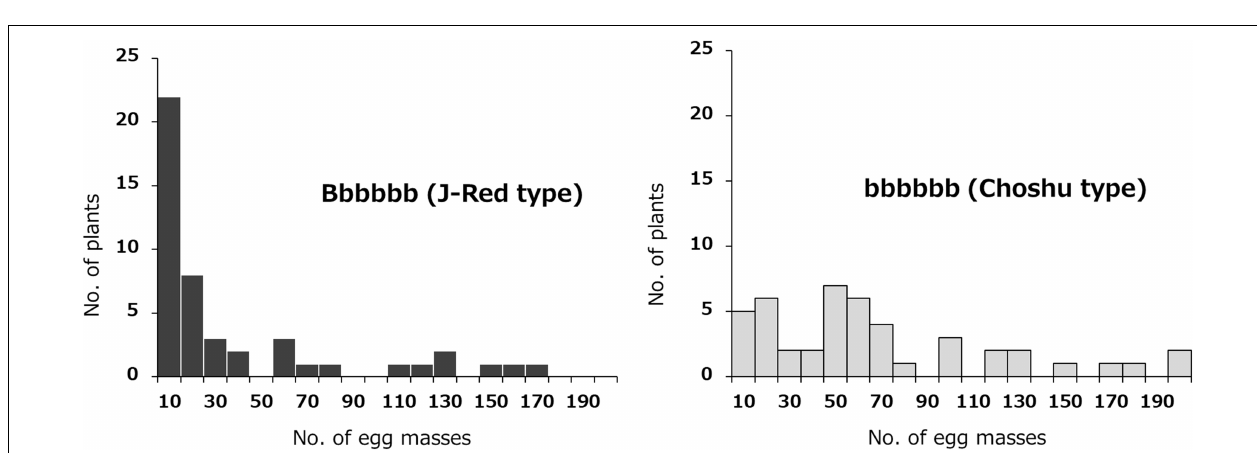
FIGURE 3 | Frequency distribution of the mean number of egg masses on F 1 lines grouped by genotype, based on the Chr07_1778460 SNP. Histograms with black and light gray indicate J-Red and Choshu genotype plants, respectively.